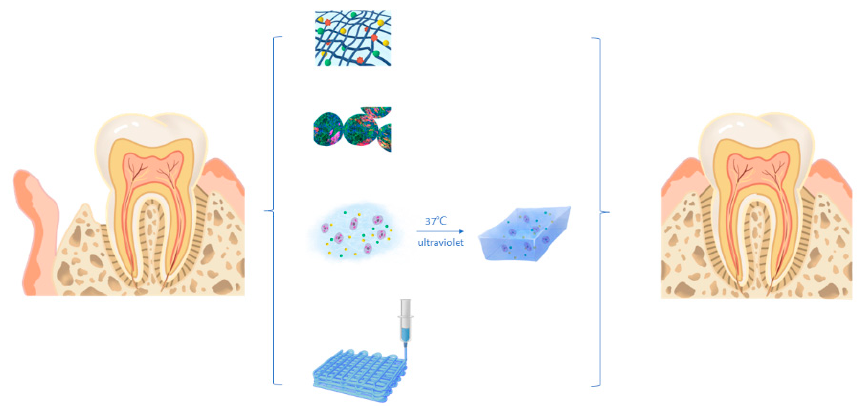
Figure 3. Application of hydrogel in periodontal tissue regeneration. 3.1. Hydrogels Loaded with Drugs or Bioactive Factors Promote Periodontal Regeneration Hydrogels containing drugs with both anti-inflammatory and tissue regeneration properties can effectively promote periodontal regeneration in periodontitis, such as BMP-2/VEGF [52]; bone morphogenetic proteins (BMP) [53]; matrix metalloproteinase 8 (MMP-8) [54]; elf-assembling peptide (SAP) [55]; bone morphogenetic protein-7 (BMP-7) [56]; insulin-like growth factor-I [57]; recombinant human beta-nerve growth factor (rh